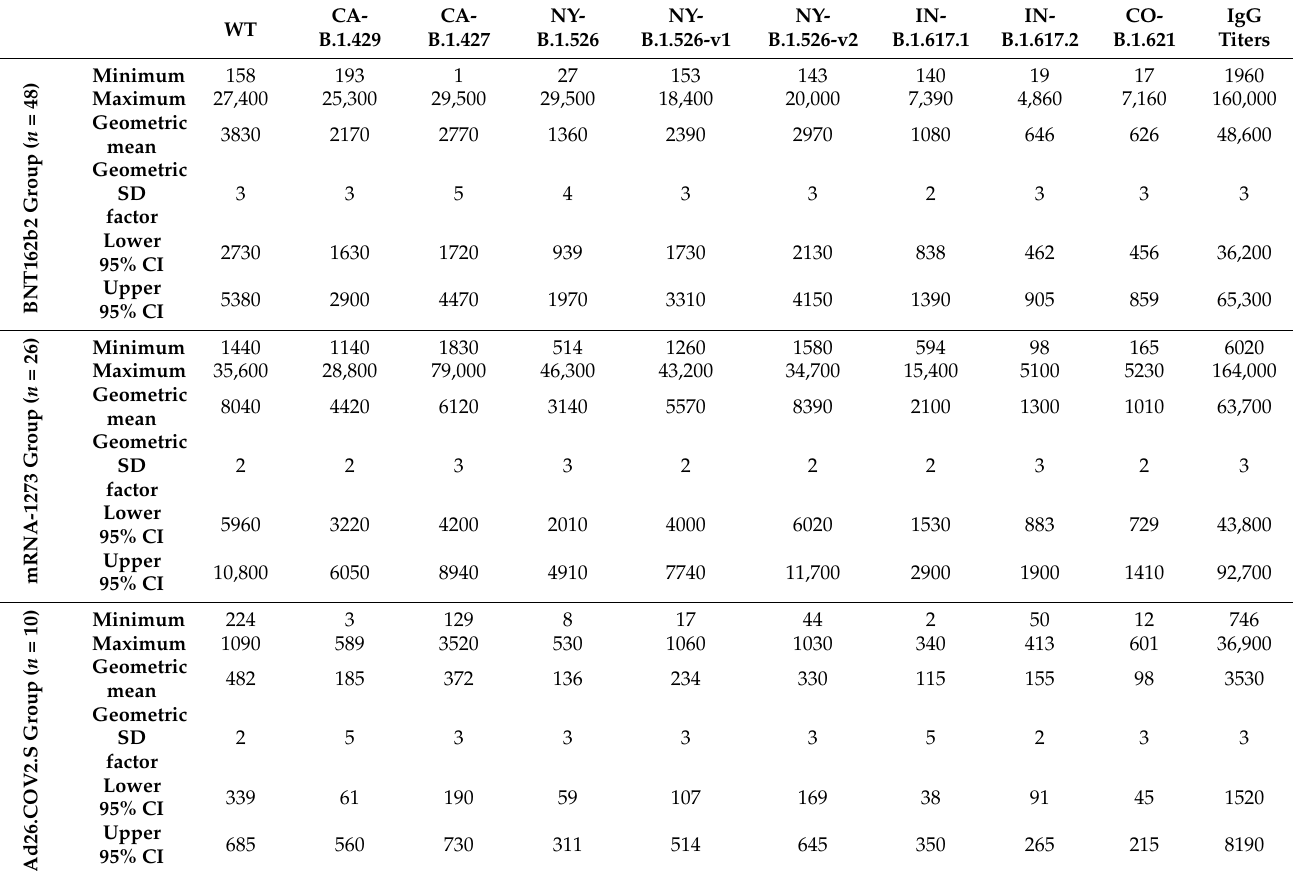
Table 1. Descriptive statistics for each group, to include interquartile values, range, geometric standard deviation (SD) factor, and 95% confidence intervals